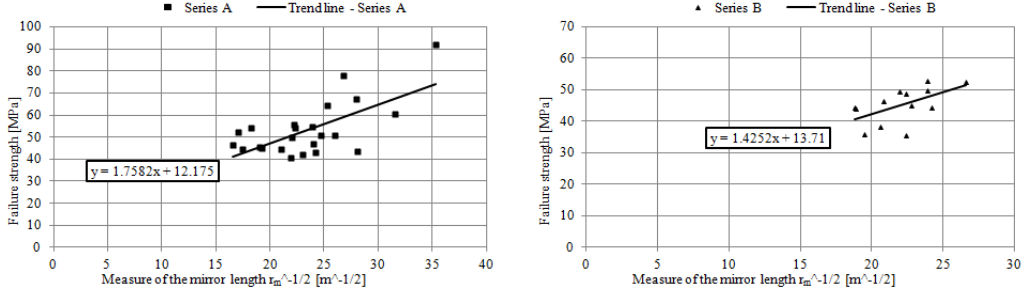
Figure 5: Diagram of the measure of the mirror length r